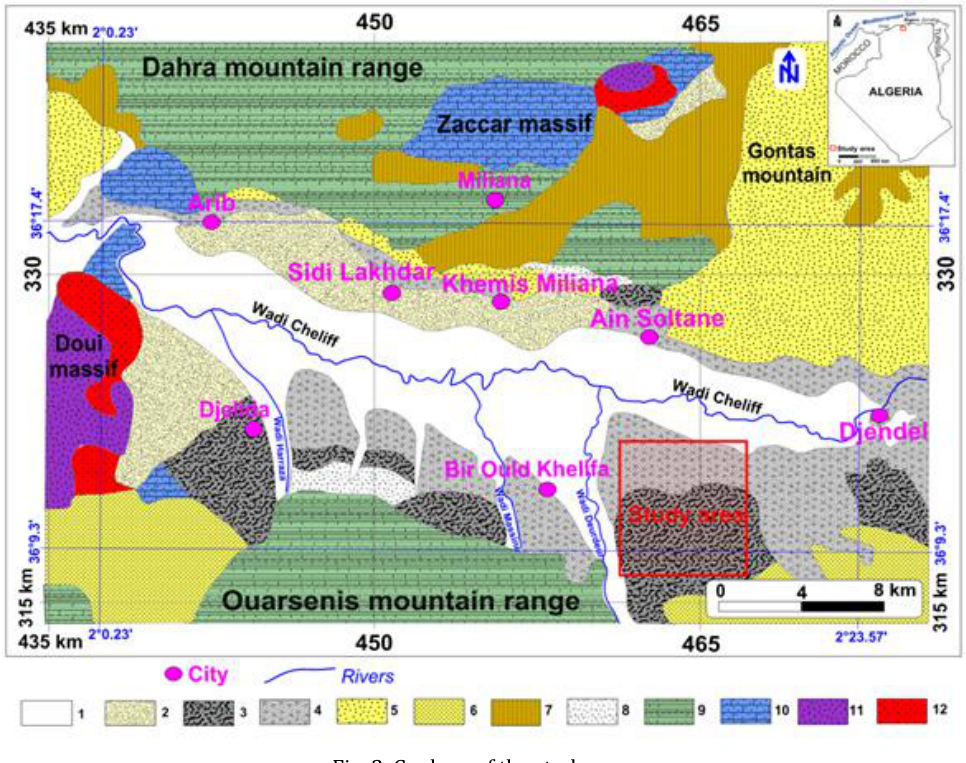
Fig. 2. Geology of the study